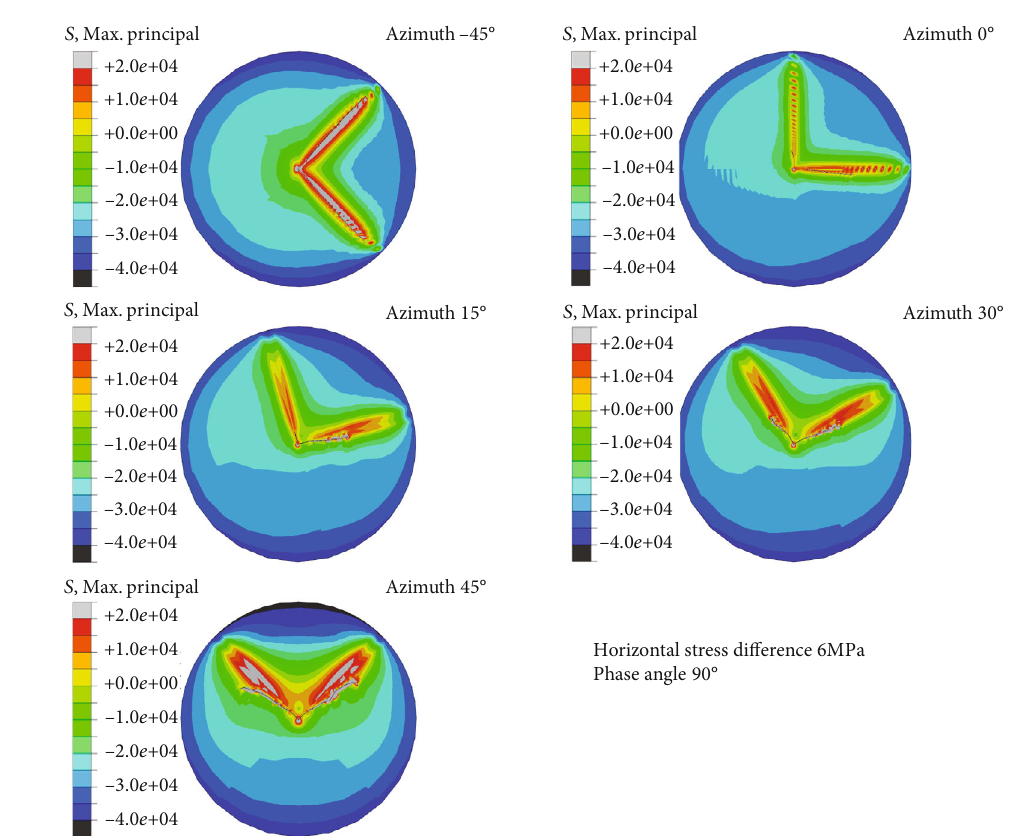
Figure 10: Fracture morphology of two radial